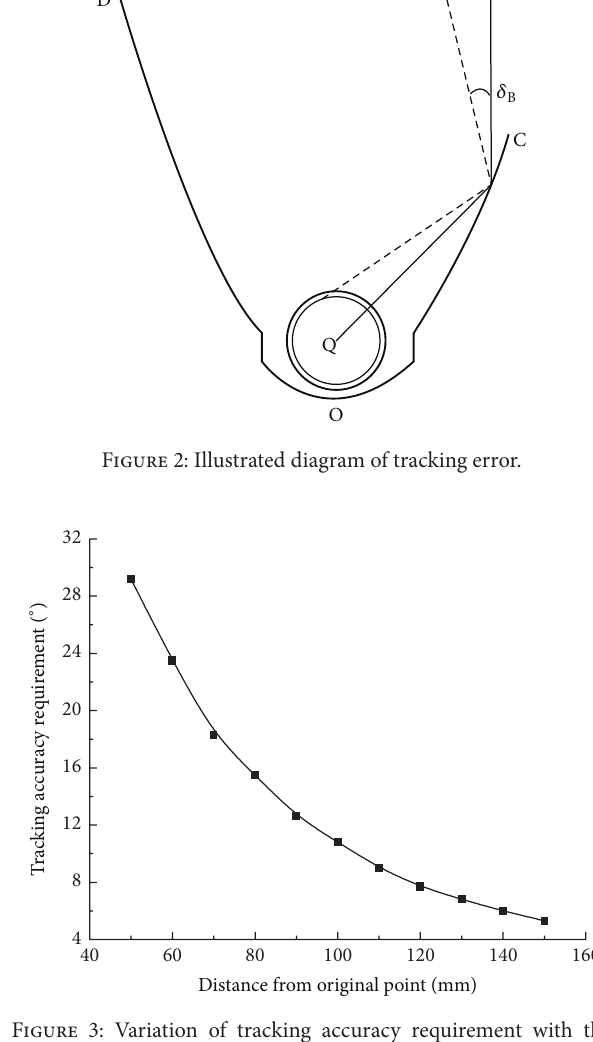
Figure 3: Variation of tracking accuracy requirement with the